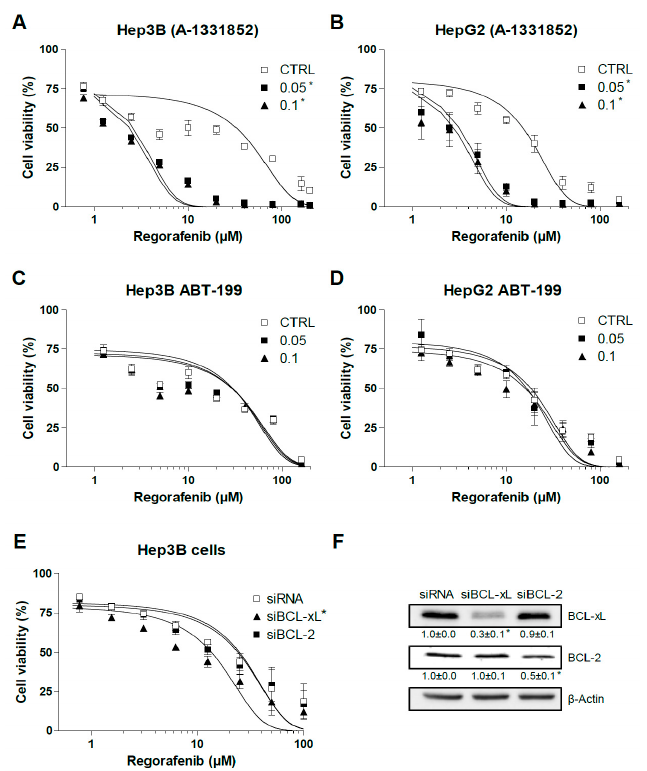
Figure 2. BCL-xL antagonism potentiates regorafenib activity on liver cancer cells. ( A,B ) Hep3B and HepG2 cells were treated for 16 h with the BCL-xL inhibitor A-1331852 and regorafenib at different concentrations, and cell viability was quantified by MTT. ( C,D ) Hep3B and HepG2 cells were treated for 16 h with the BCL-2 inhibitor ABT-199 and regorafenib at different concentrations, and cell viability was quantified by MTT. ( E ) Hep3B cells were transfected with siRNA control or against BCL-xL and BCL-2 and after 48 h treated with regorafenib at di ff erent concentrations, and cell viability was quantified by MTT. ( F ) RNA interference was confirmed and protein levels of BCL-xL, BCL-2, and β -actin are shown in parallel panels. (n = 3) * p < 0.05 vs. control or siCTRL